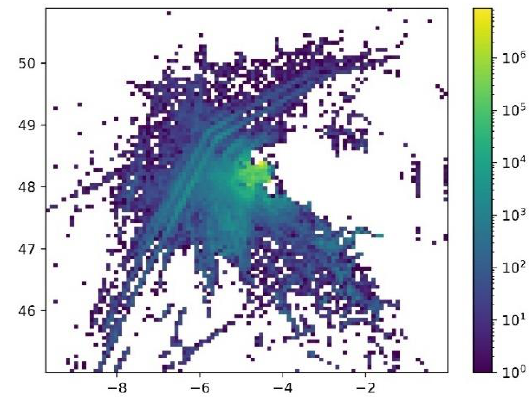
Figure 5. Grid map of maritime traffic density.